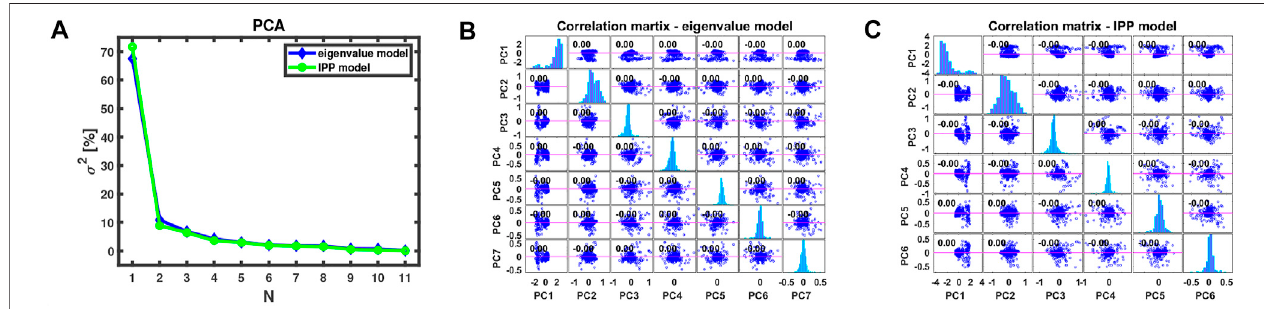
FIGURE3| (A) PCA forNnumber ofcomponents,explainingthe correspondingpercentage ofvariance σ 2 for both submodels.Correlationmatricesfor (B) 7 PCs and their scores — eigenvalue model and (C) 6 PCs and their scores — IPP model.